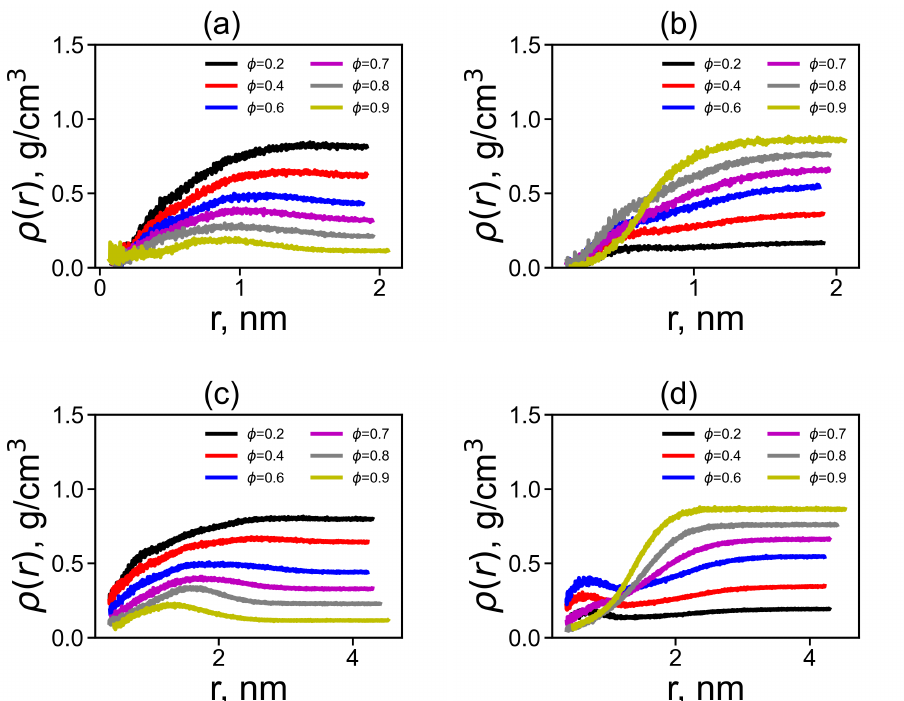
Figure 6. The radial distribution function of the density ρ ( r ) as a function of distance r from the center of mass of the dendrigraft at different methanol fractions for water molecules ( a ) around DGL1, ( c ) around DGL2, for methanol molecules ( b ) around DGL1, and ( d ) around DGL2 at different methanol fractions φ .